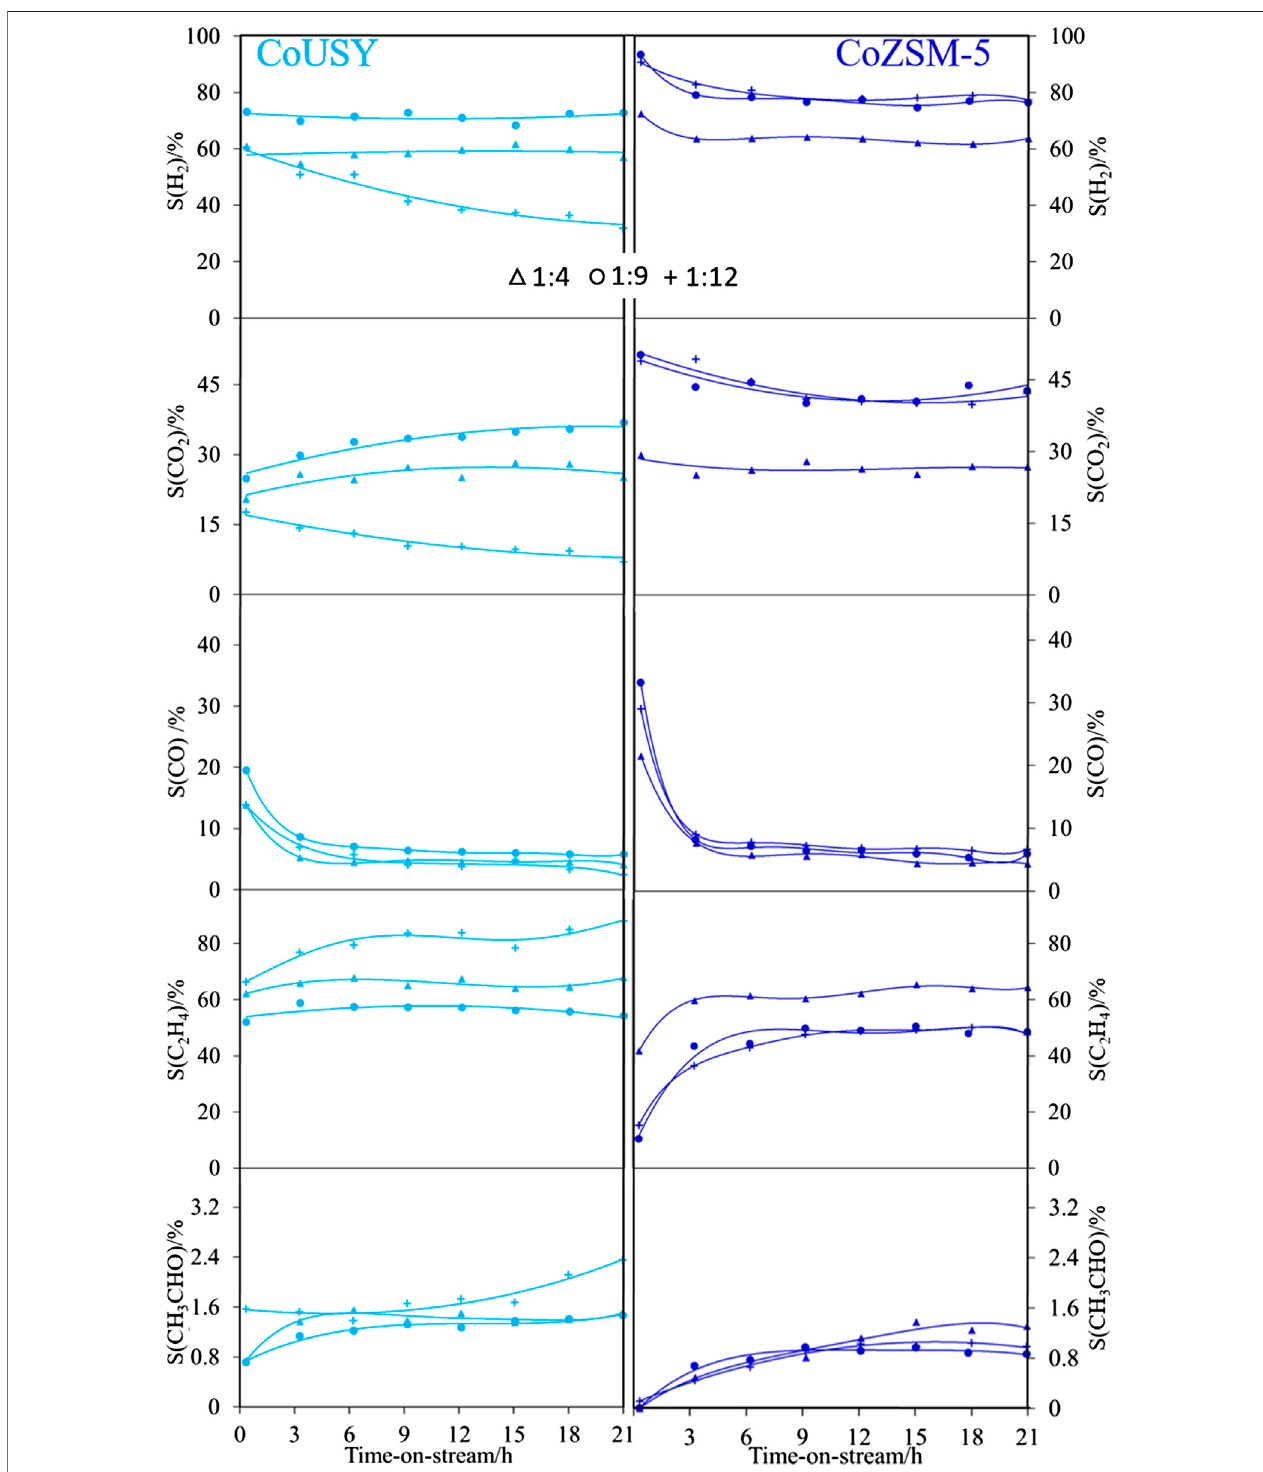
FIGURE 8 | Selectivity to the main products of the ESR process at 500 ° C for reaction mixtures with ethanol-to-water ratio of 1 : 4 ( Δ ), 1 : 9 (o), and 1 : 12 (+) for the CoUSY (left column) and CoZSM-5 (right column) catalysts.